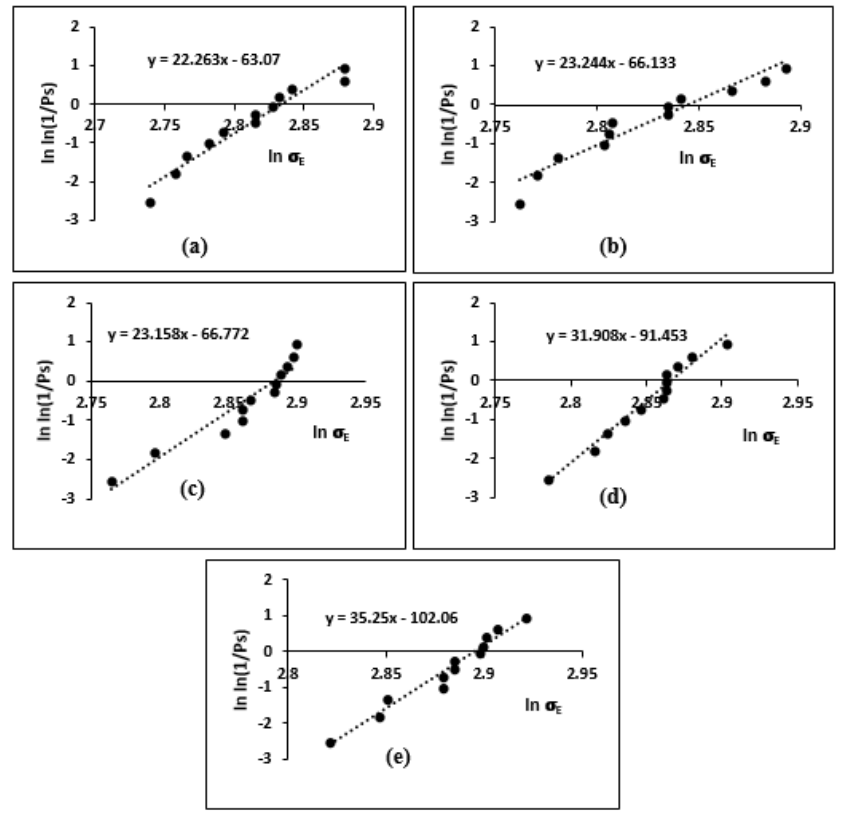
Figure 3: Weibull distribution of dielectric strength at various RRV: (a) 0.5, (b) 1, (c) 2, (d) 3 and (e) 5 kV/s, for 1 wt% Al 2 O 3 .